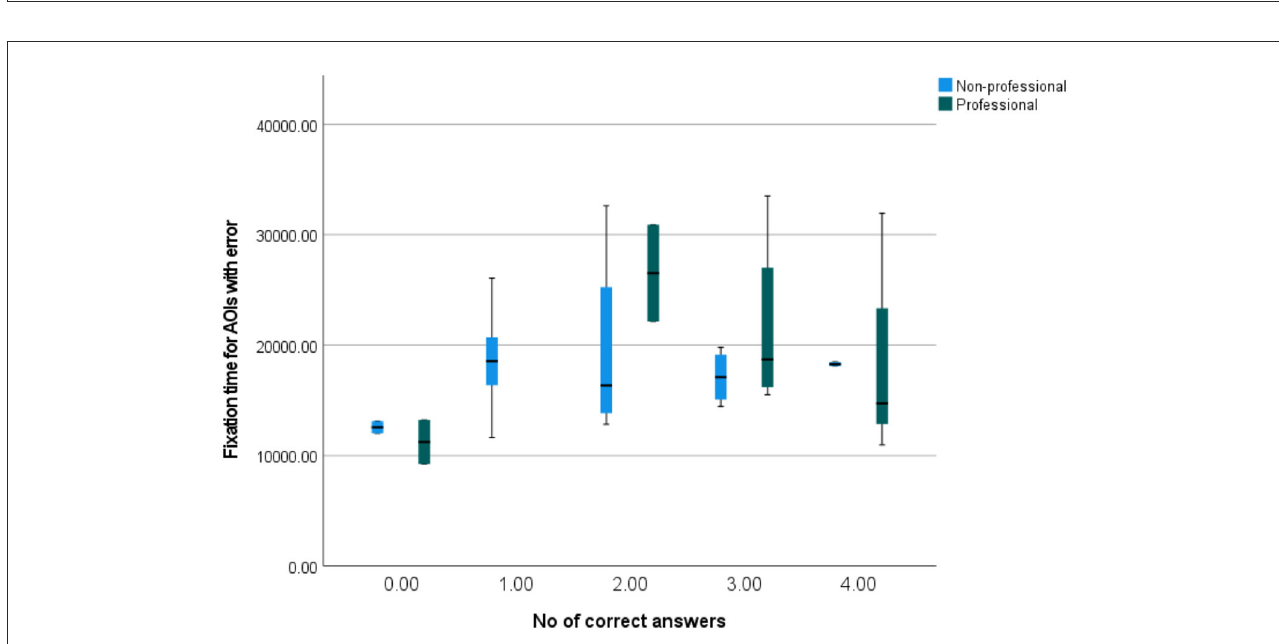
FIGURE12 A simple box plot of fixation times for AOIs with errors by the number of correctly answered